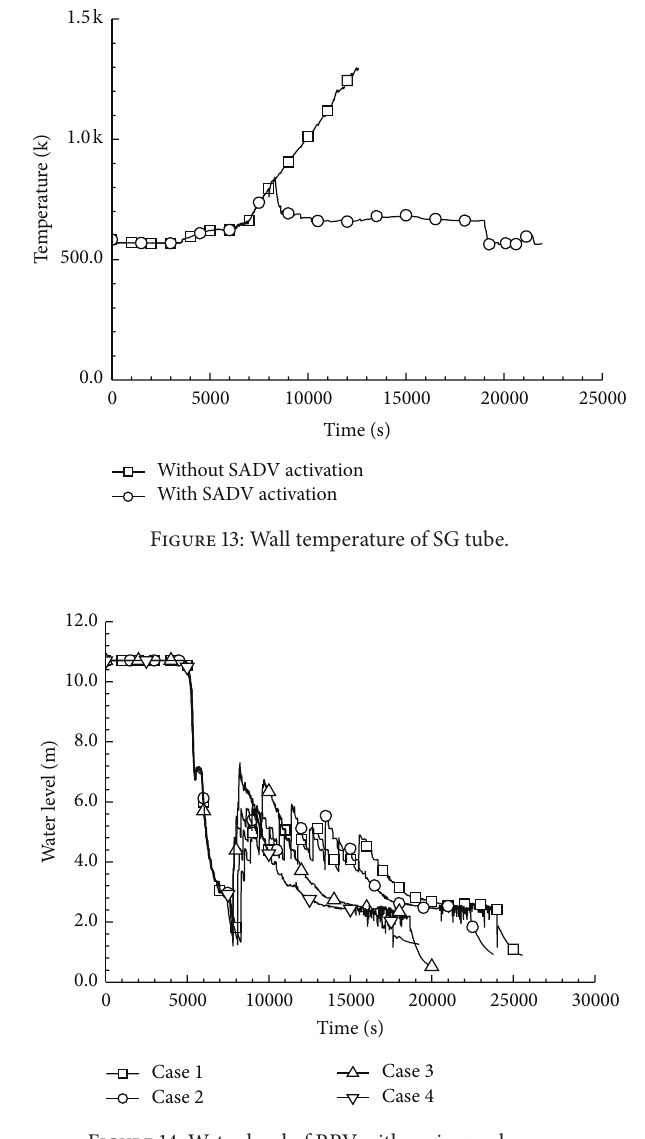
Figure 14: Water level of RPV with various valve area.